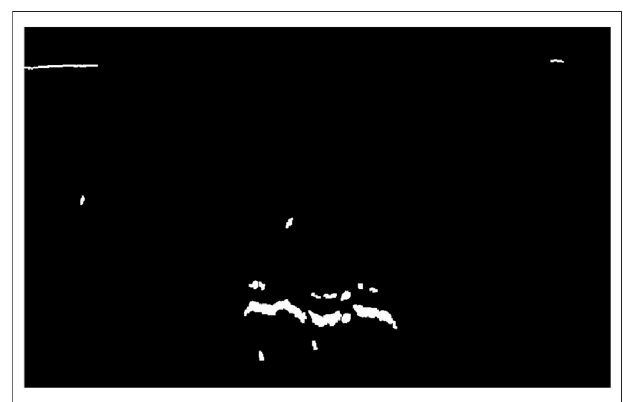
FIGURE 4 | Binary image after etching treatment.